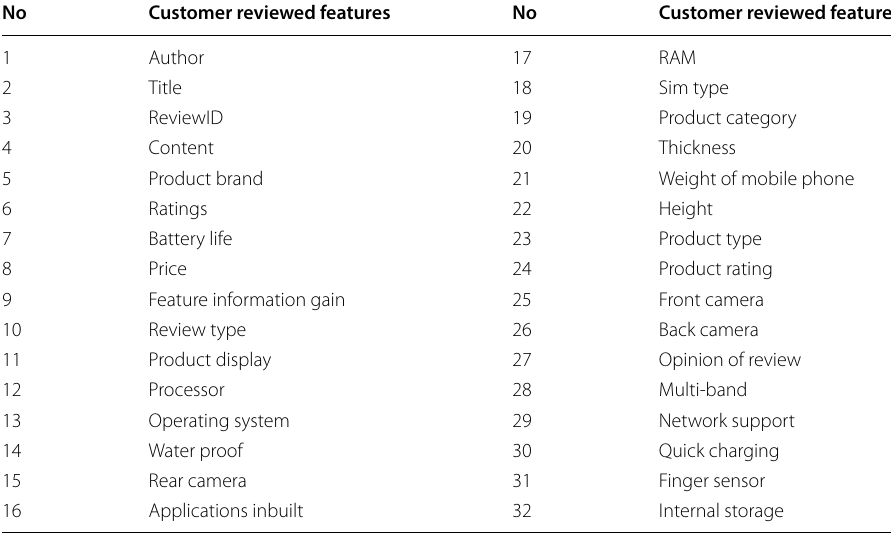
Table 2 Significant Features from Customer Reviews and